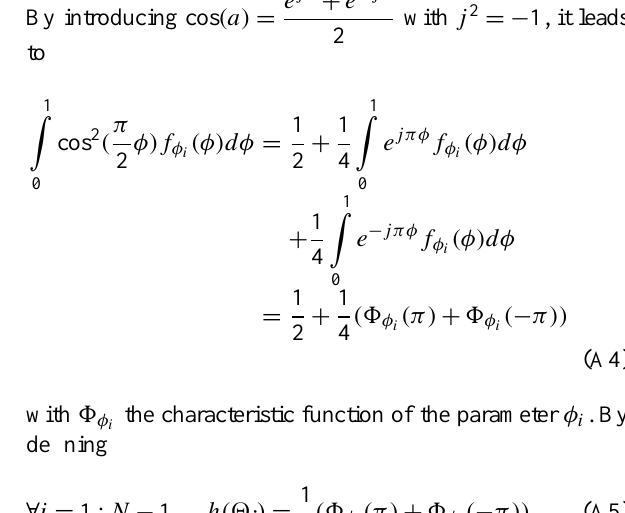
Fig. 6. Time evolution of the Pearson correlation coefficients be- tween the surface chlorophyll and the meso- and microzooplankton grazing preferences during the first year (no assimilation) and av- eraged over the 20 experiments, for the spherical formulation. The evolution of the averaged surface chlorophyll concentration due to diatoms (resp. flagellates) is plotted with a dark dotted line (resp. with a dark dash-dotted